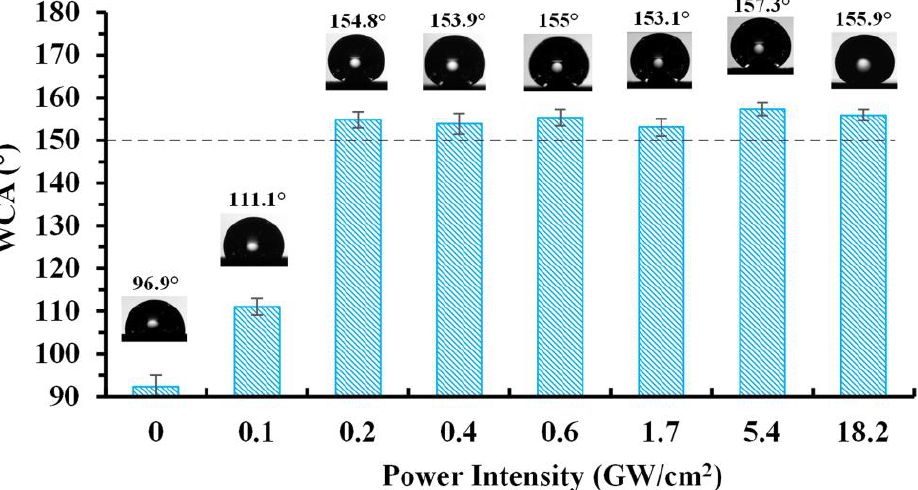
Figure 8. Contact angle variation of AISI 4130 stainless steel specimens produced at various laser power intensities. Reproduced with permission from [69]. power intensities. Reproduced with permission from